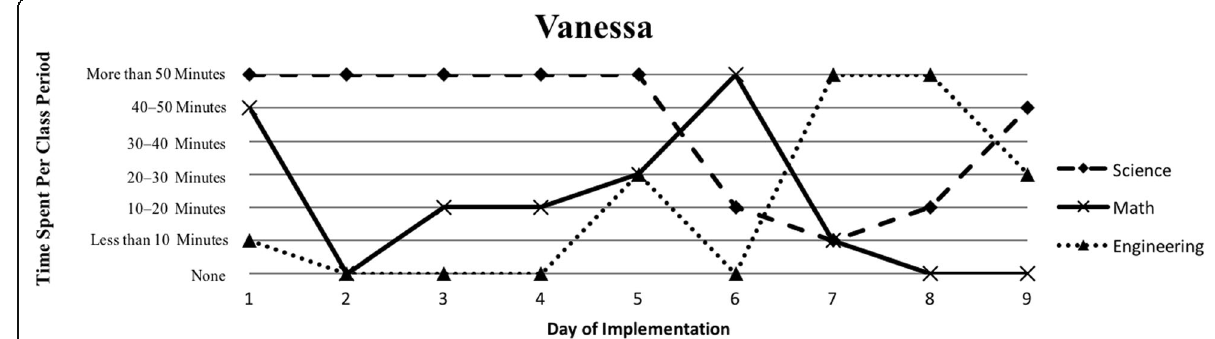
Fig. 8 Vanessa ’ s implementation of the Heat Transfer 2 in her 6th grade science class